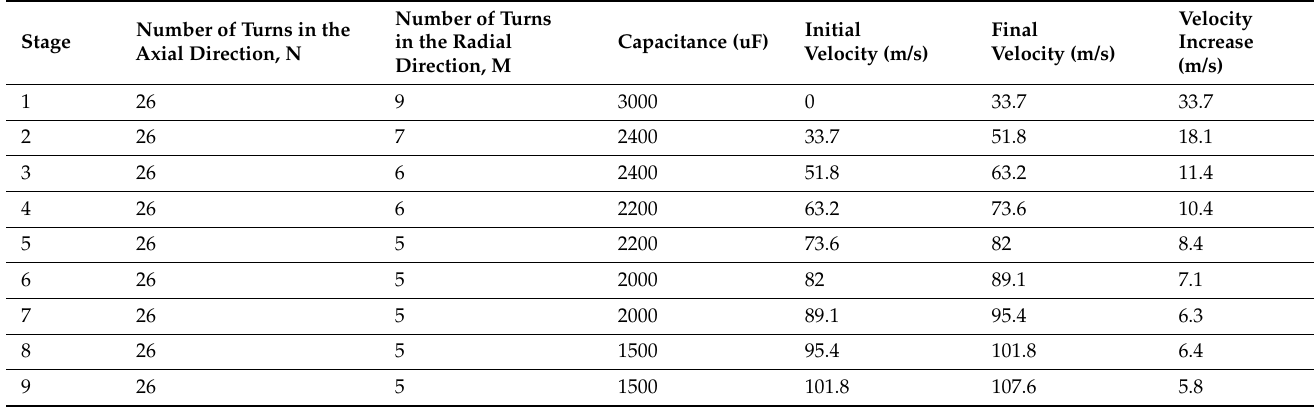
Table 3. Solenoid coil shape, capacitance, and increases in the projectile’s velocity by